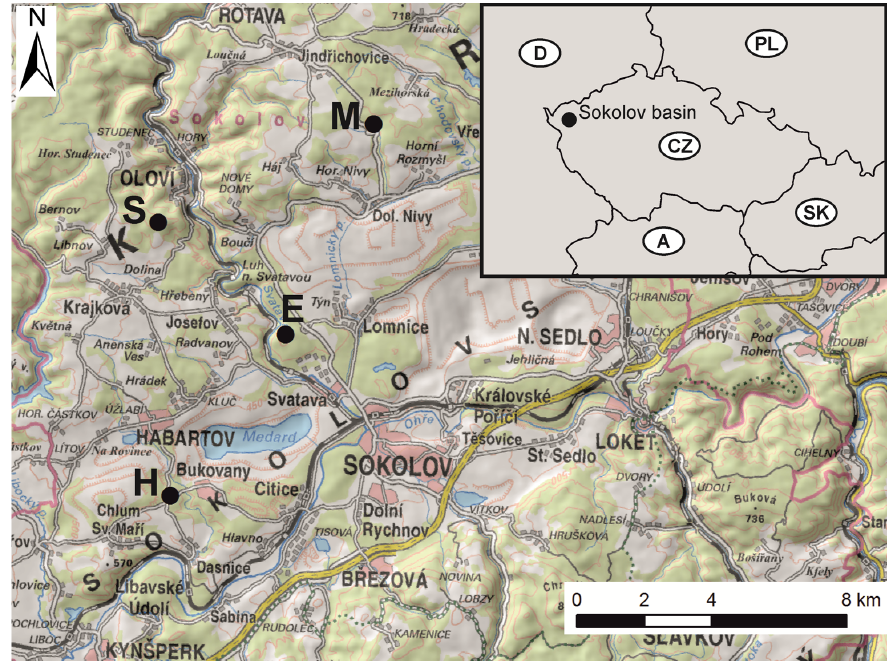
Figure 1. Location of the Sokolov lignite basin in the western part of the Czech Republic. Four sampled Norway spruce stands: Erika (E), Habartov (H), Mezihorská (M) and Studenec (S). Background map © Č UZK.